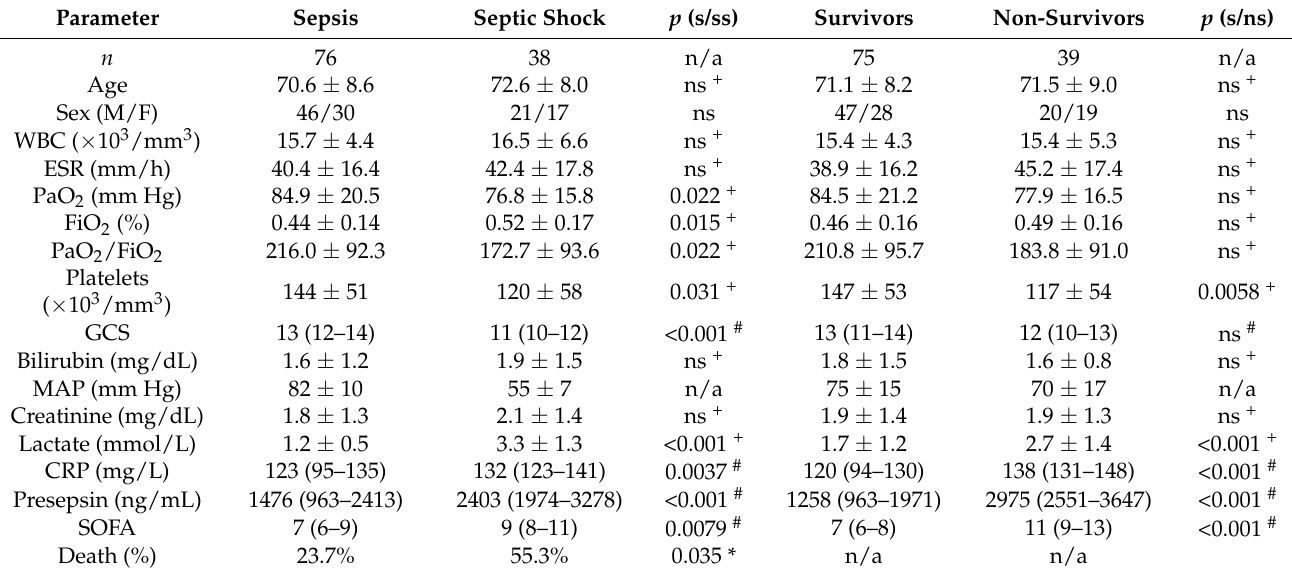
Table 1. Patients’ characteristics (ns = not-significant, n/a = not applicable, * = Fisher’s exact test, # = Mann–Whitney U test, + = Student t -test, s/ss = sepsis vs. septic shock, s/ns = survivors vs. non-survivors). Data presented as mean ± SD or median and (25–75% quartile range).